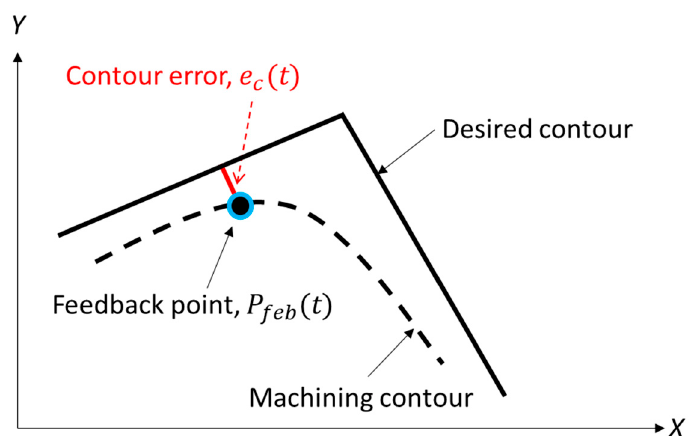
Figure 6. Definition of contour error.